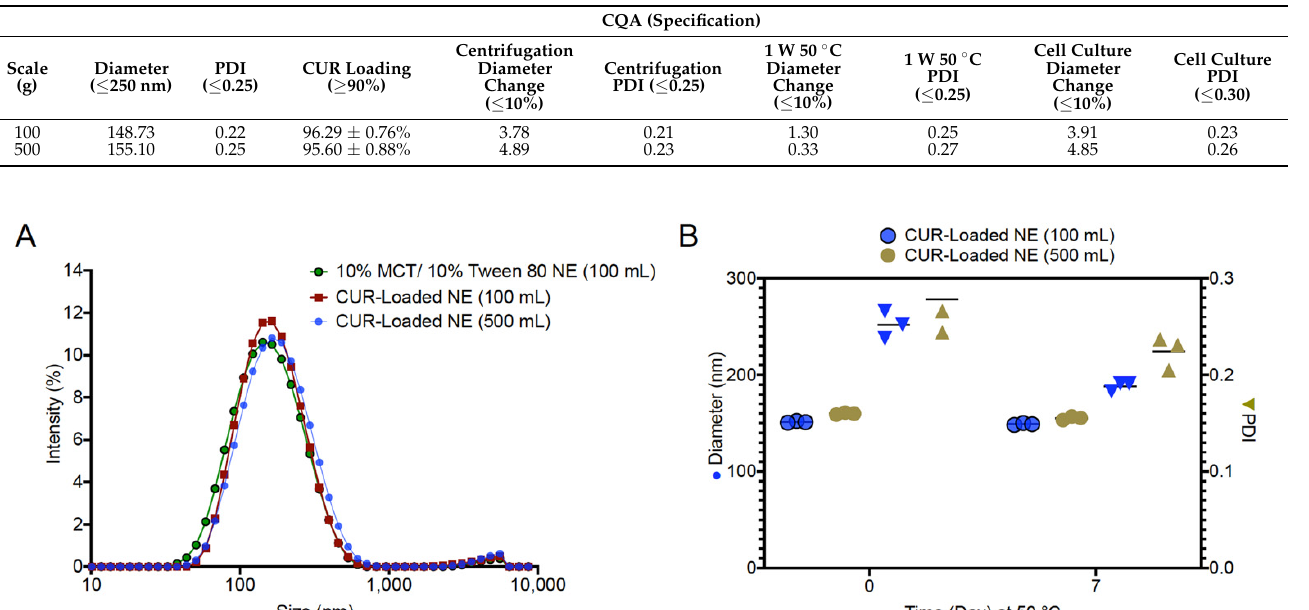
Table 5. Summary of CQA specification testing for CUR-loaded nanoemulsion and scale-up.